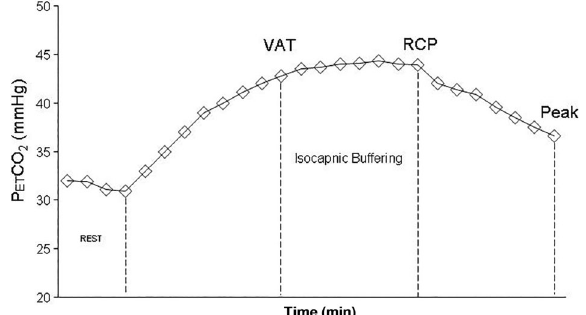
Figure 1. End-tidal CO 2 pressure (P ET CO 2 ) response during incremental exercise test in a healthy subject. VAT: ventilatory anaerobic threshold; RCP: respiratory compensation